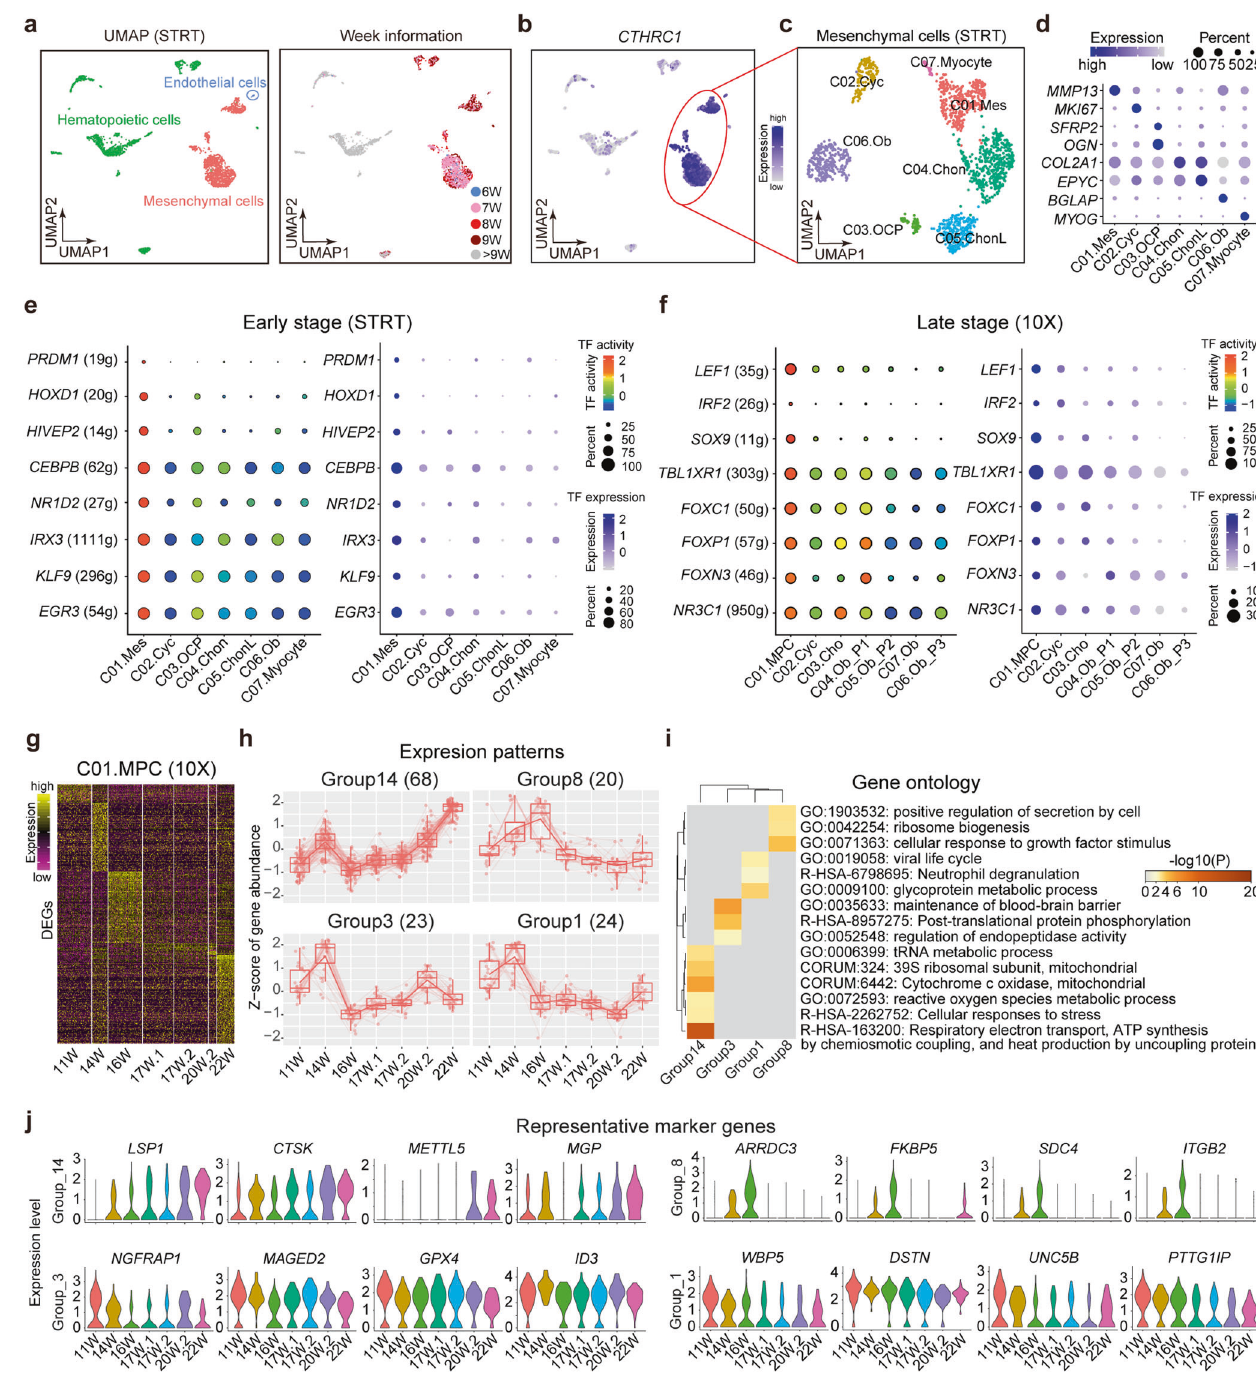
Fig. 3 Discrepancy between MSCs at early and late developmnental stages. a UMAP showing the three major groups (left) and their developmental stages (right) of all randomly picked fresh cells from human fetal BM at early stages. b UMAP showing the speci fi c expression of CTHRC1 in mesenchymal cells. c UMAP showing the 7 clusters of mesenchymal cells at early stages. d Dotplot showing the expression levels of representative marker genes in each cluster identi fi ed in Fig. 3c. The color key from light blue to dark blue indicates low to high expression levels, respectively. Dot size indicates the percent of cells expressing a certain gene. e TFs that were speci fi cally activated and expressed during the early developmental stages. f TFs that were speci fi cally activated and expressed during the late developmental stages. g The development of MSCs at late stages identi fi ed in Fig. 2d. Heatmap showing the DEGs of MSCs at each stage. The color key from purple to yellow indicates low to high expression levels, respectively. h Selected expression patterns along the development of MSCs. The gene number is in the bracket. i Enriched terms using the genes of each expression pattern along the development of MSCs. j Violin plots showing the expression levels of marker transcription factors along the development of MSCs